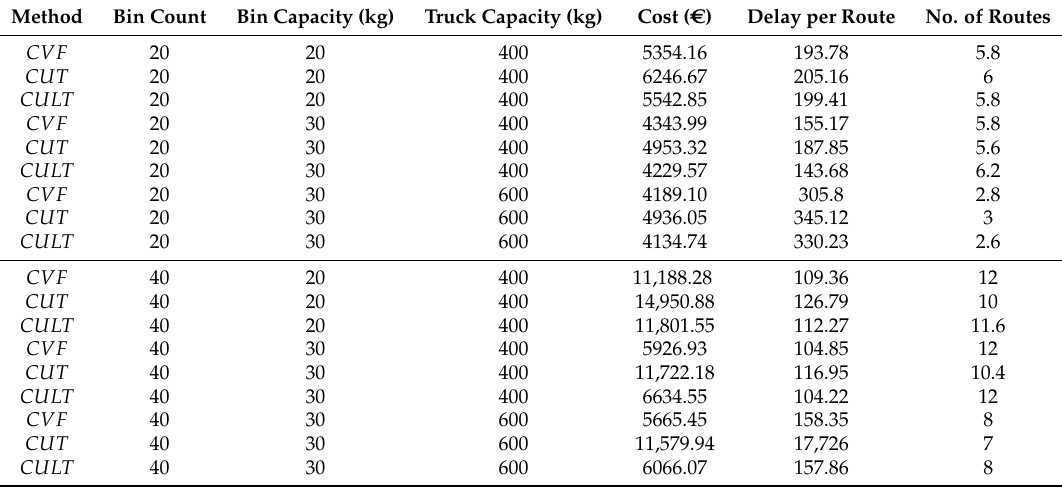
Table 3. Cost when λ = 1 kg/5